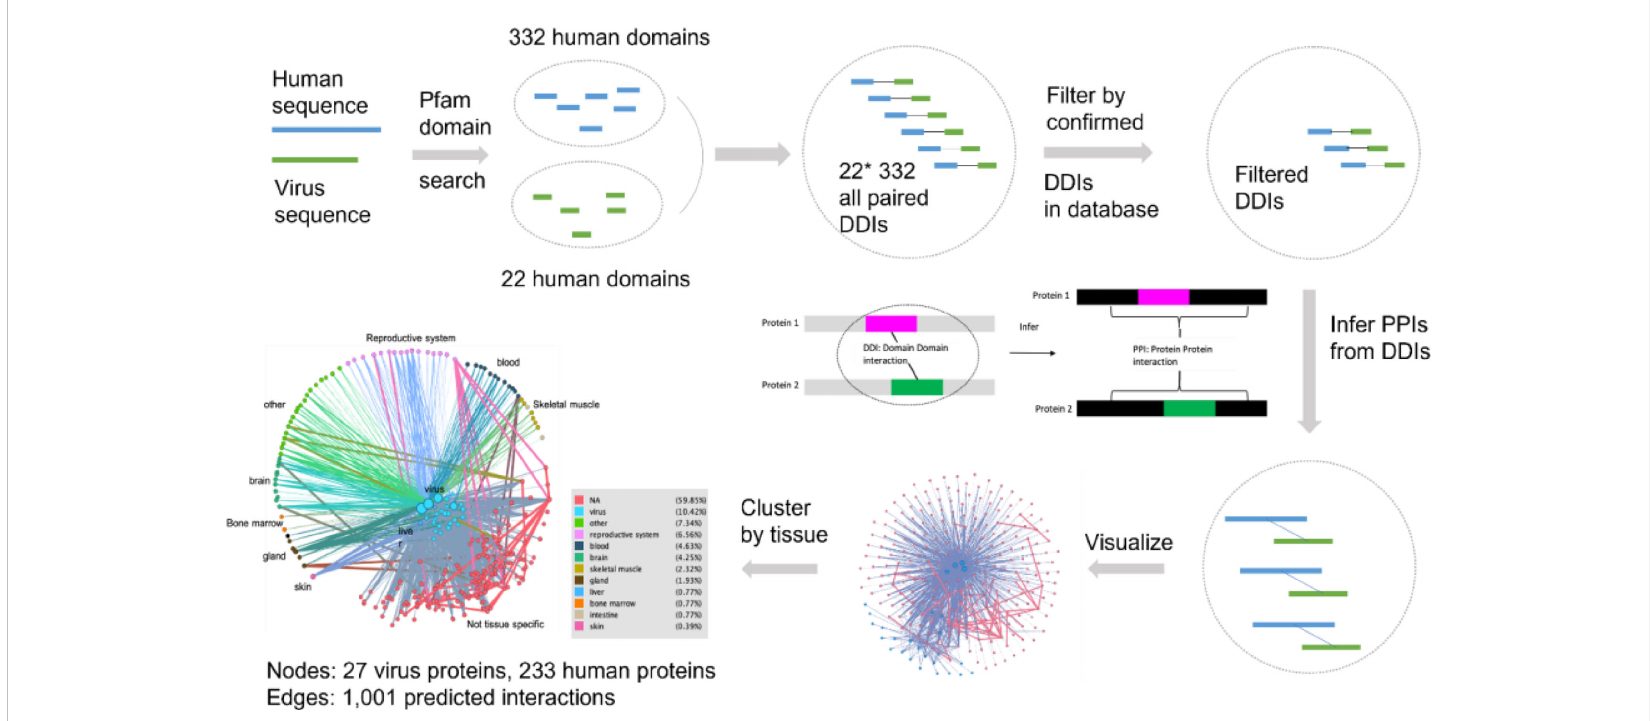
FIGURE 6 Predicted human-coronavirus protein-protein interactions (PPIs) and their affected tissues. The predicted 1,001 interactions that involve 27 virus proteins and 233 human proteins are detailed in Supplemental File 3. The predicted tissue speci fi city results are provided in the Supplemental File 4. See the text for more